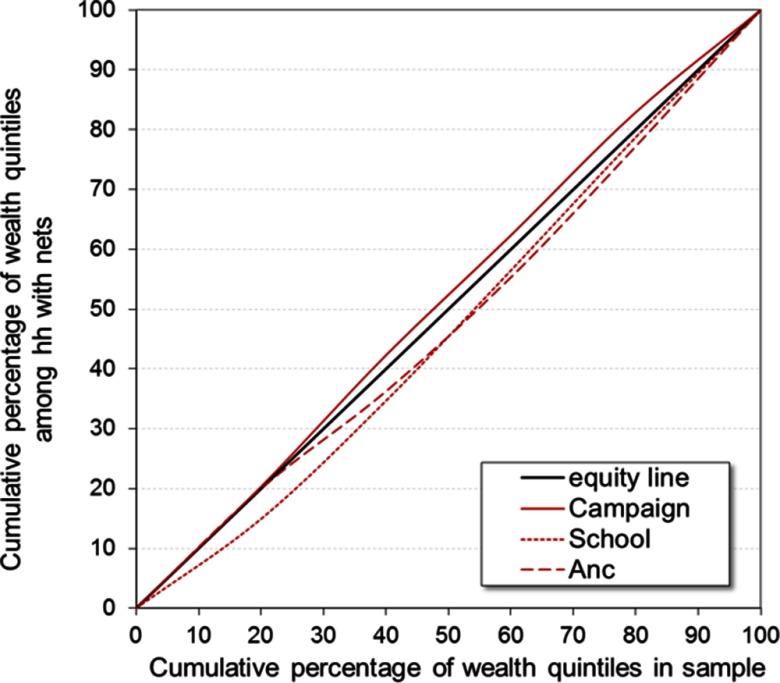
Lorenz Concentration Curve Assessing Equity in Household ITN Ownership by Source of NetAbbreviations: Anc, antenatal care; hh, household; ITN, insecticide-treated net.